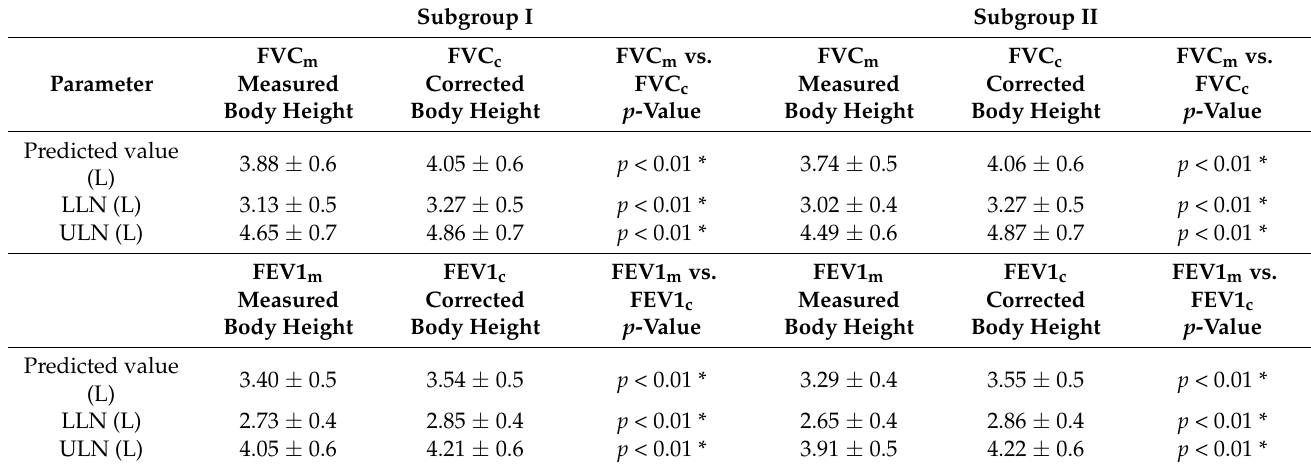
Table A2. Comparison of the predicted values of the pulmonary parameters calculated (GLI 2012, [17]) for the measured versus the corrected body height in subgroup I, N = 54, and subgroup II, N = 19, Lenke 1